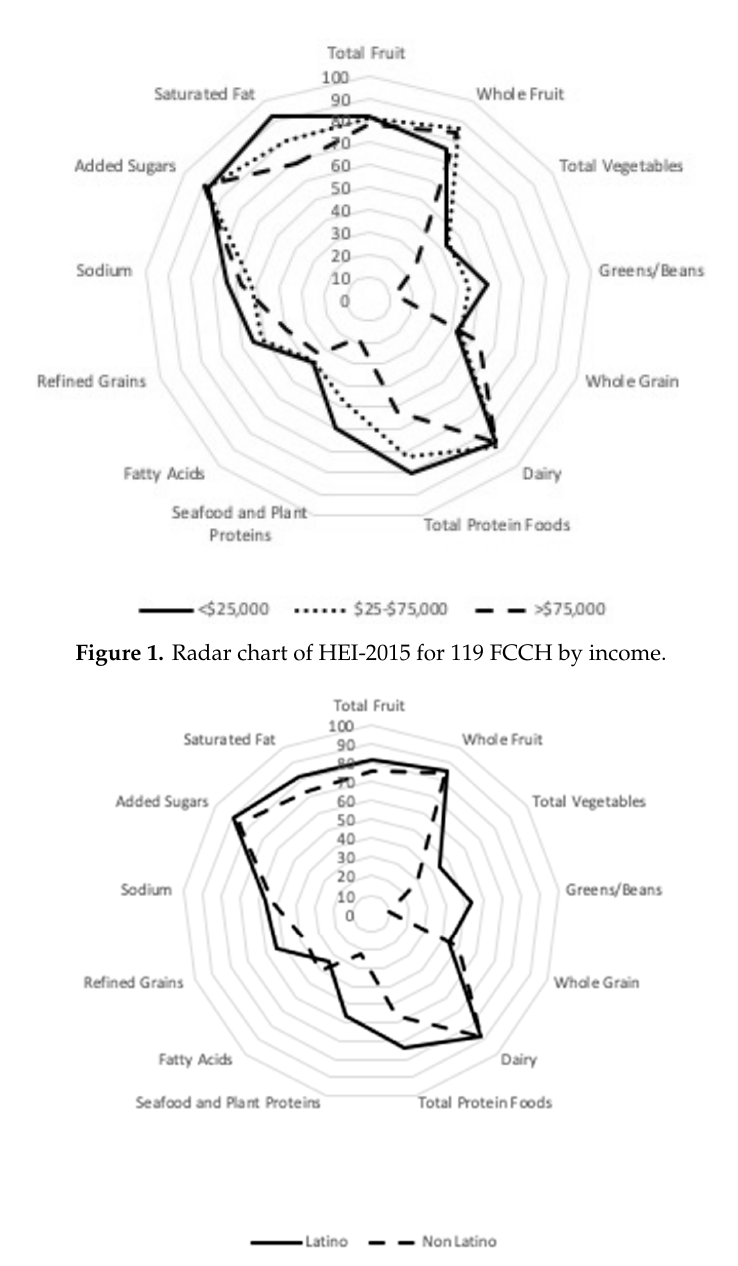
Figure 2. Radar chart of HEI-2015 for 119 FCCH by ethnicity.